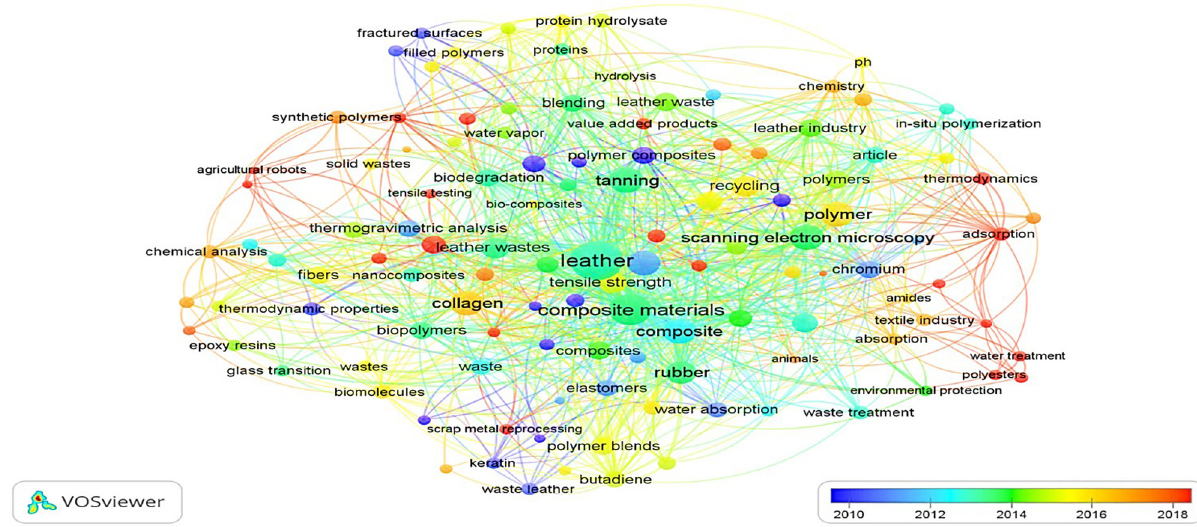
Figure 1: Mapping scientometrics analysis